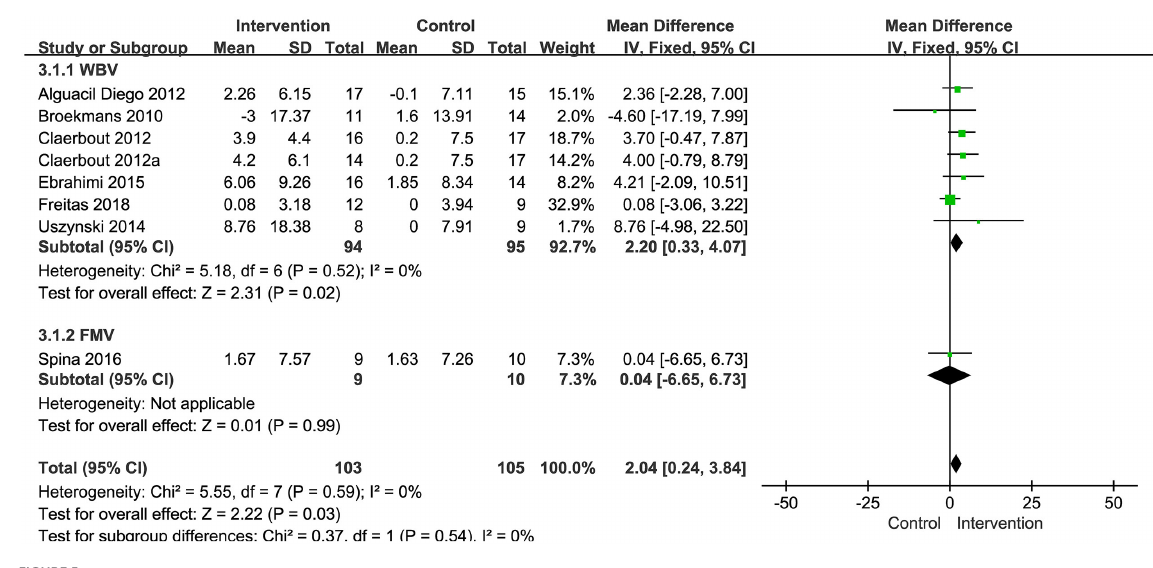
FIGURE5 Forest plot showing the effects of vibration therapy on balance.